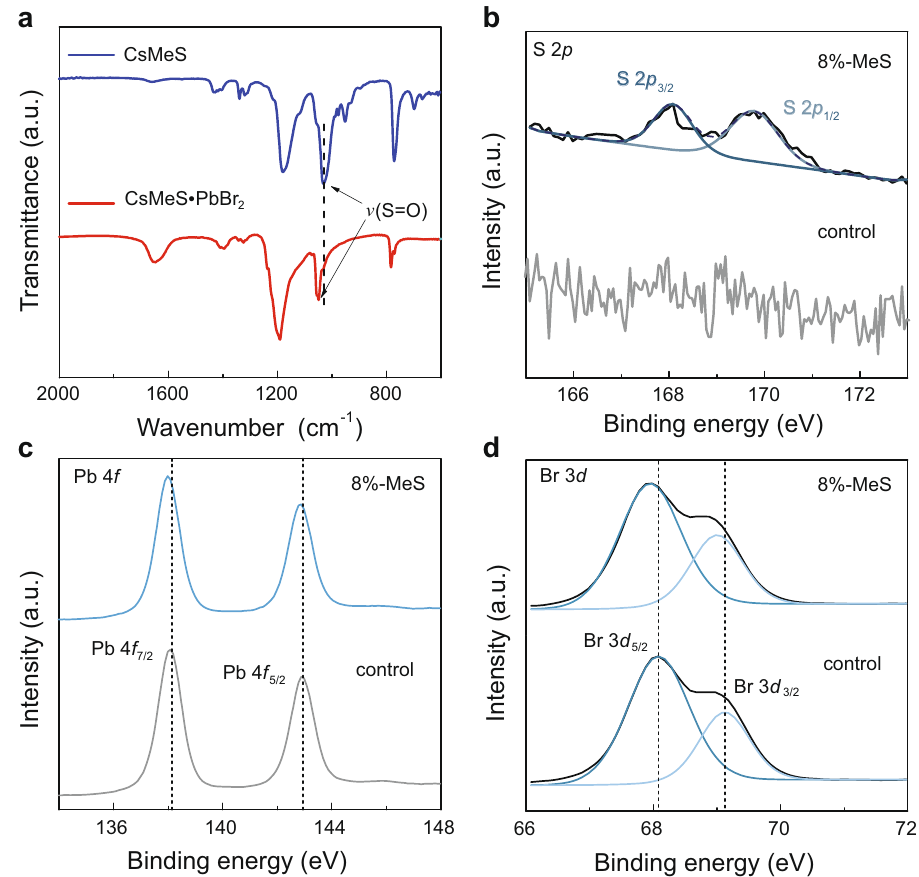
Fig. 4 FTIR and XPS spectra. a FTIR spectra of powdered CsMeS and CsMeS·PbBr 2 , and high-resolution XPS spectra of the control and MeS-treated fi lms for: b S 2 p , c Pb 4 f , and d Br 3 d